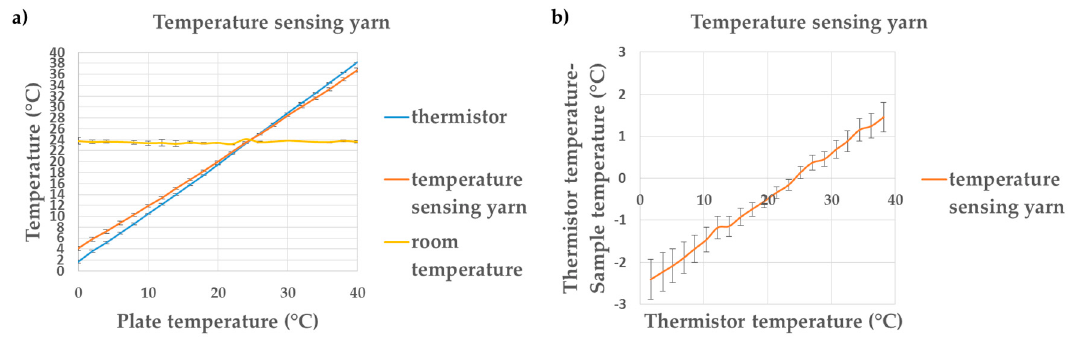
Figure 4. Temperature sensing yarns created using 9-20801 resin micro-pod s . ( a ) The effects of increasing the plate temperature on the temperature recorded by the thermistor and the temperature sensing yarns; ( b ) The difference between the temperature recorded by the samples compared to the thermistor